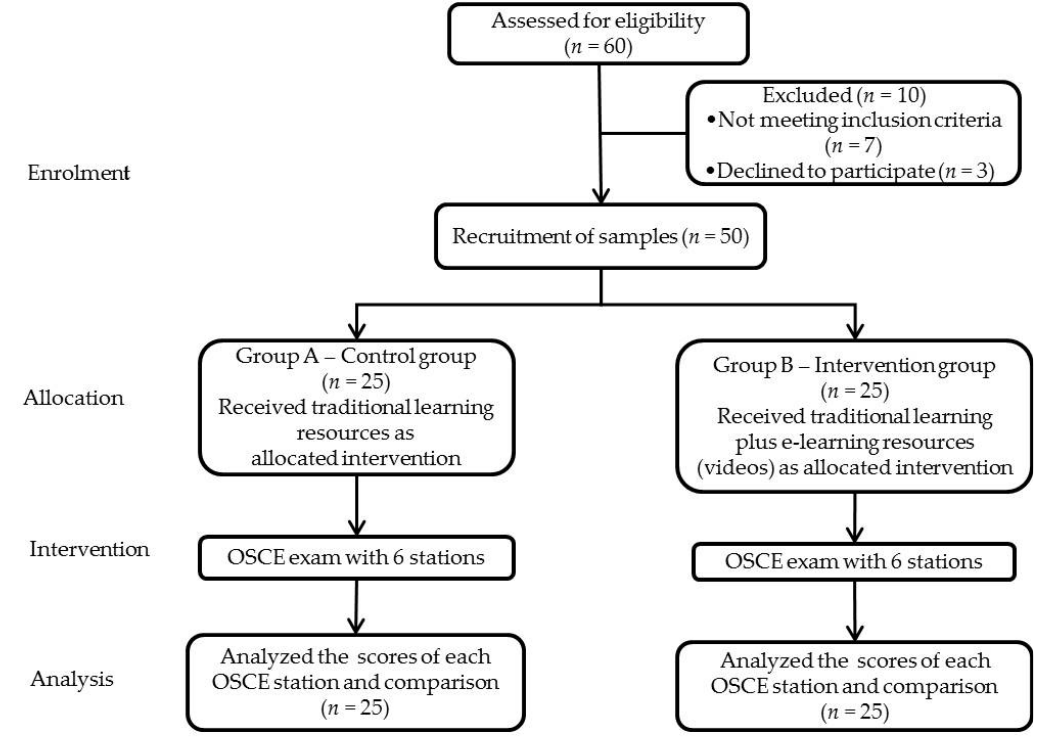
Figure 1. Consort chart for randomization, intervention and follow-up of study samples.